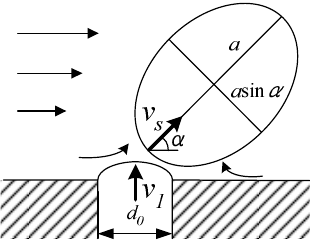
Fig. 5 Coalescence of separating bubble and jet from the